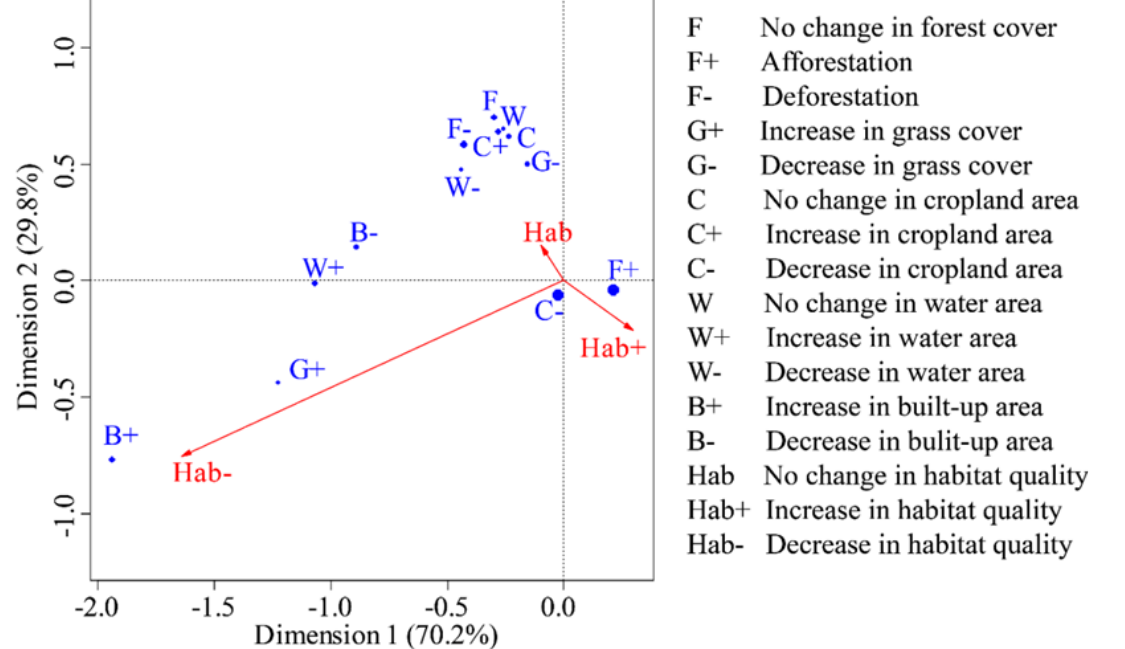
Figure 7. Correspondence analysis between habitat quality changes and land use changes.